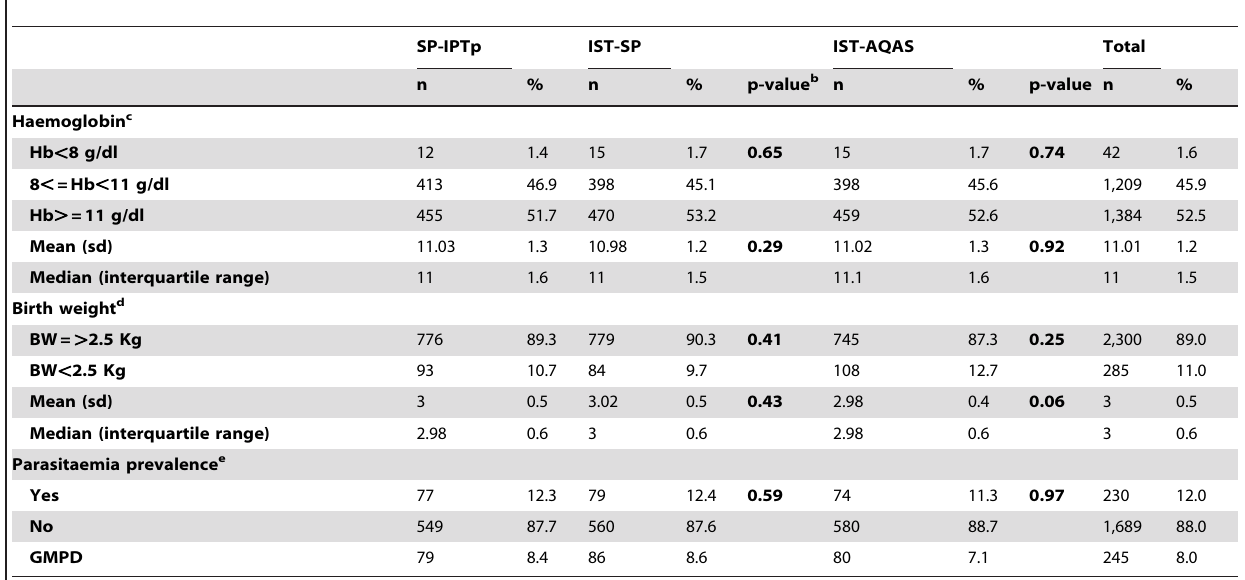
Table 2. Comparison a of key outcomes in women enrolled in SP-IPTp or IST